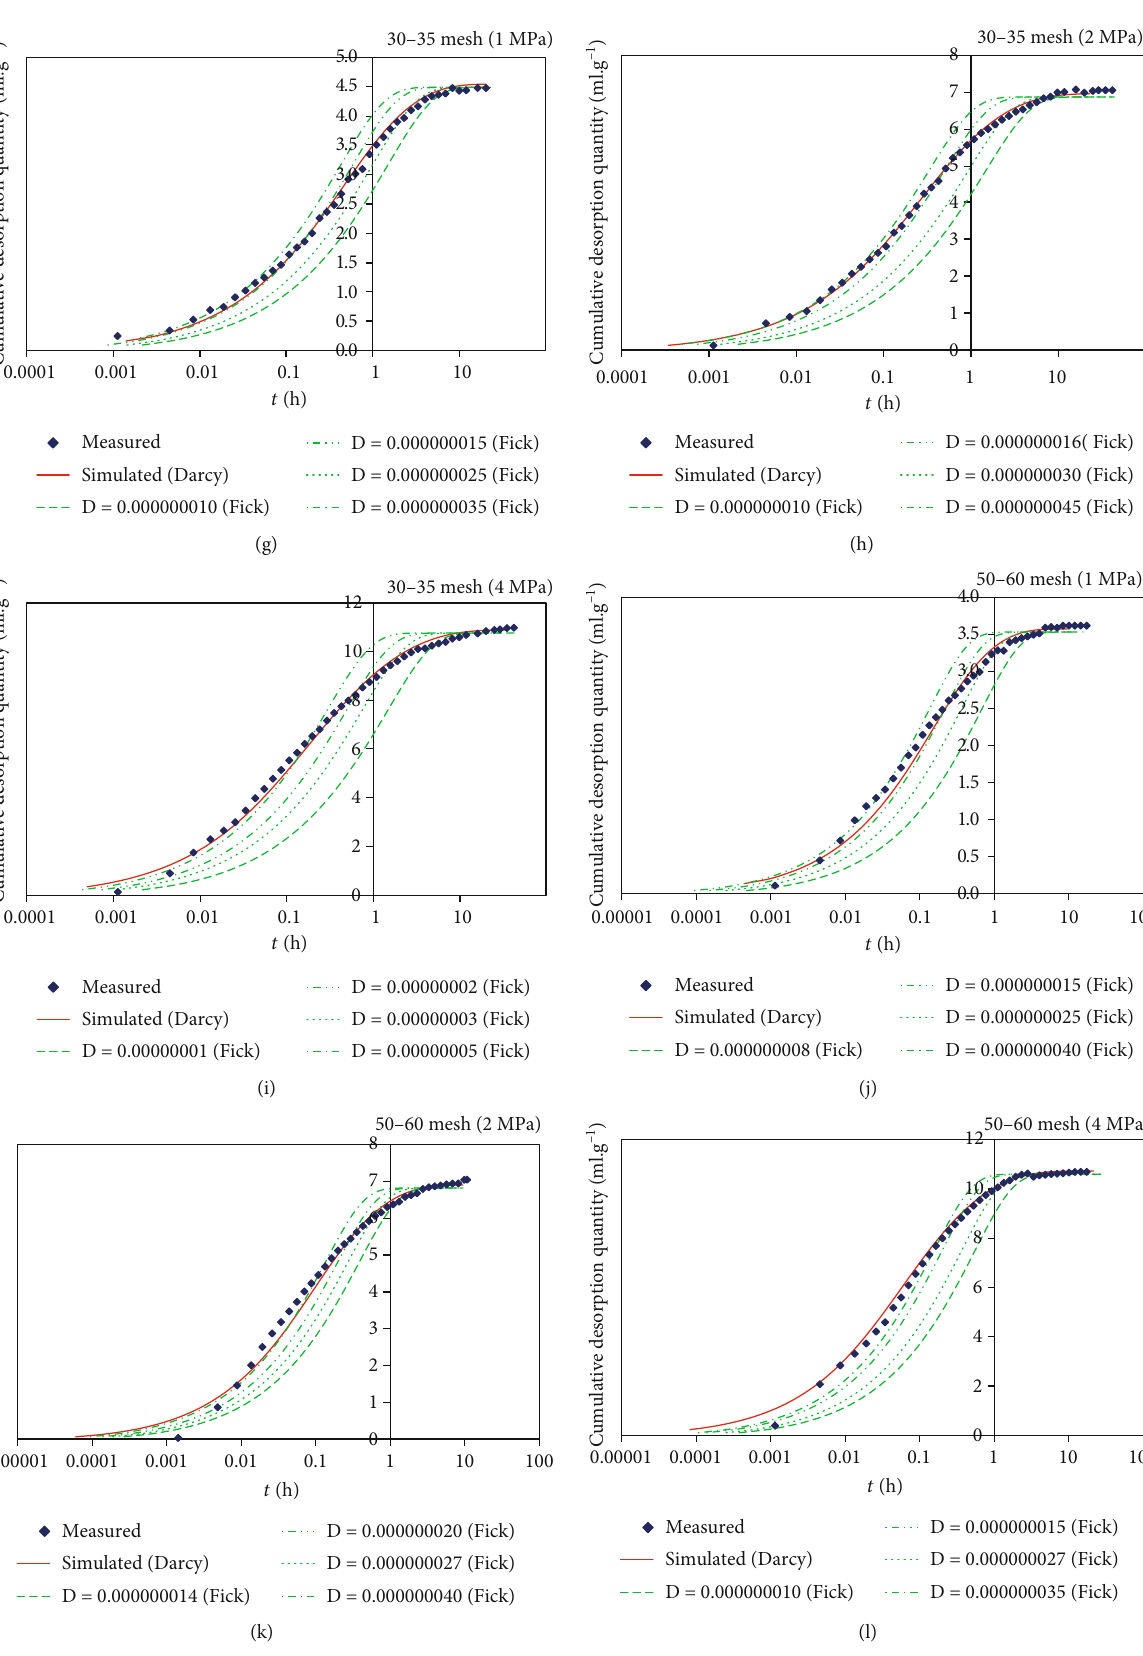
Figure 6: Contrast curves between simulated CMDQ and experimental